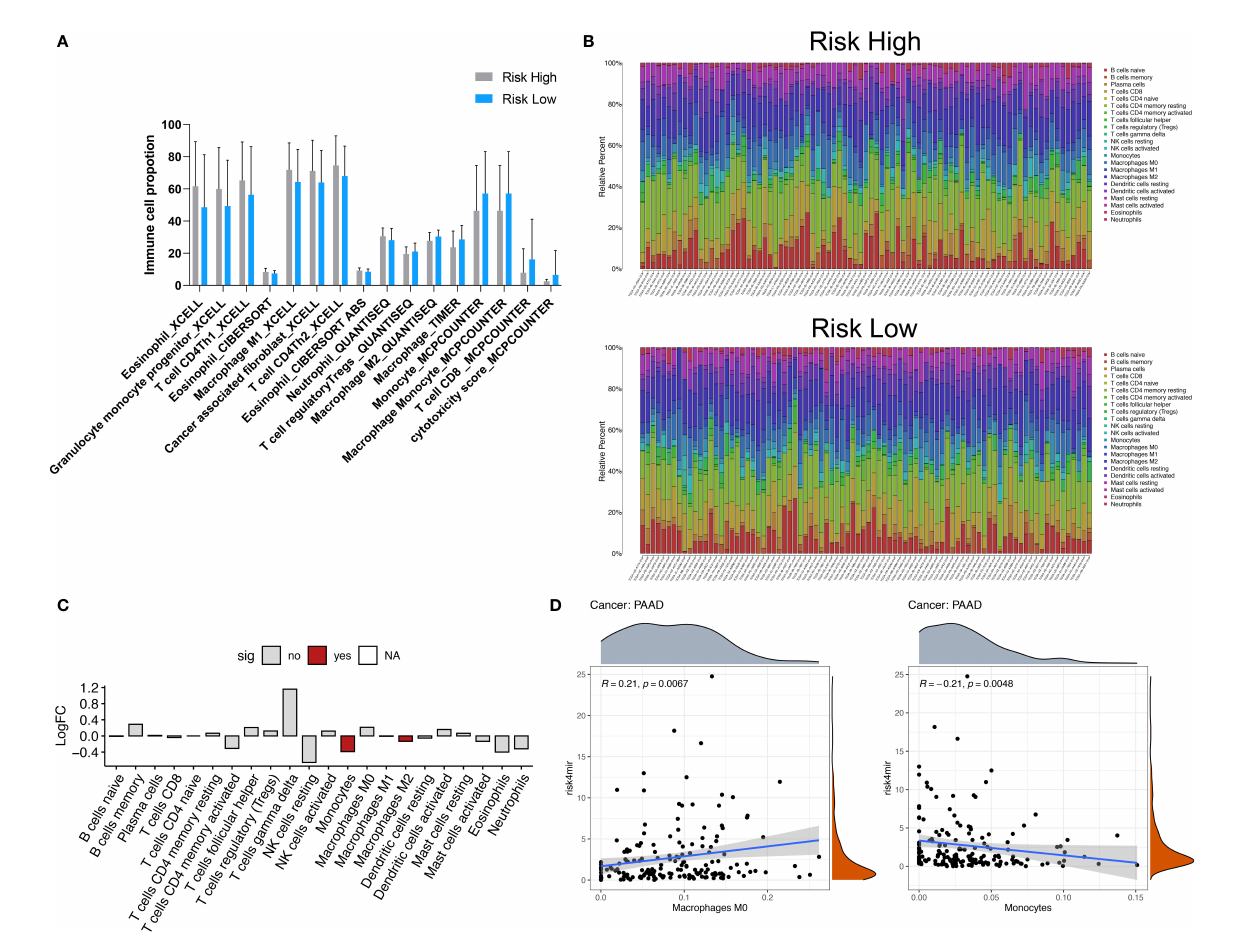
FIGURE 6 | Immune cell type analyses correlated to 4 miRNA risk groups. (A) Comparison of the in fi ltrated immune cell levels between the high- and low-risk groups. The immune in fi ltrates scores based on CIBERSORT, XCELL, TIMER and MCPCOUNTER algorithms were retrieved from TIMER 2.0 database (http://timer. cistrome.org/). All the signi fi cant changed immune cell types was showed (Wilcoxon test, P < 0.05). (B) The abundance of 22 types of immune cells in TCGA PAAD based on CIBERSORT algorithms. (C) The signi fi cant differential immune cells types based on CIBERSORT algorithms. (D) The dot plot showed risk scores positively correlated with Macrophage M0 (R=0.21, P=0.0067) and negatively correlated with monocyte (R=-0.21,